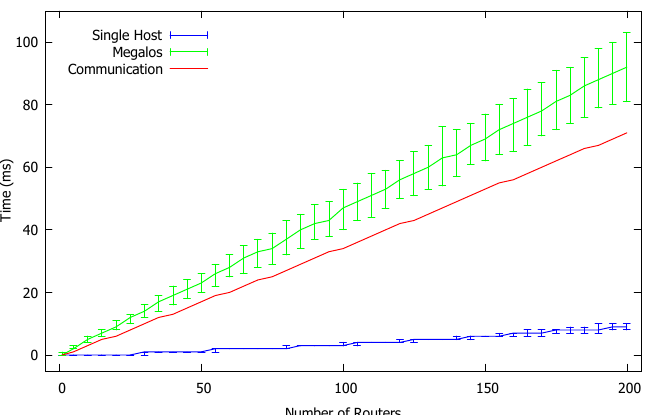
Figure 4. Results of the latency test. The green and the blue curves show the RTT measured in the scenario composed by a chain of n routers. The green curve corresponds to the Megalos implementation while the blue curve corresponds to the single-host one. The red curve represents the portion of RTT that is either intrinsic of the inter-container communication or depends on the physical latency of the